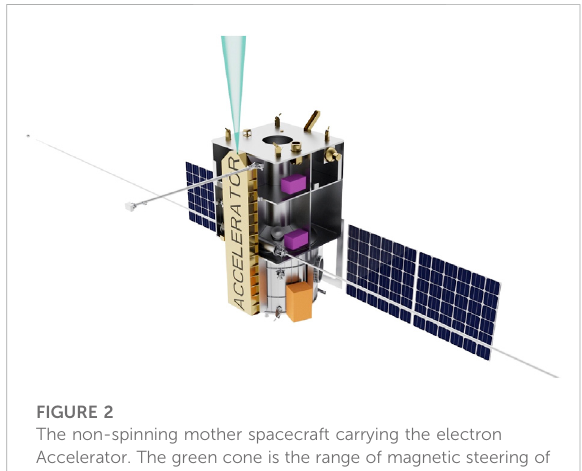
FIGURE 2 The non-spinning mother spacecraft carrying the electron Accelerator. The green cone is the range of magnetic steering of the relativistic electron